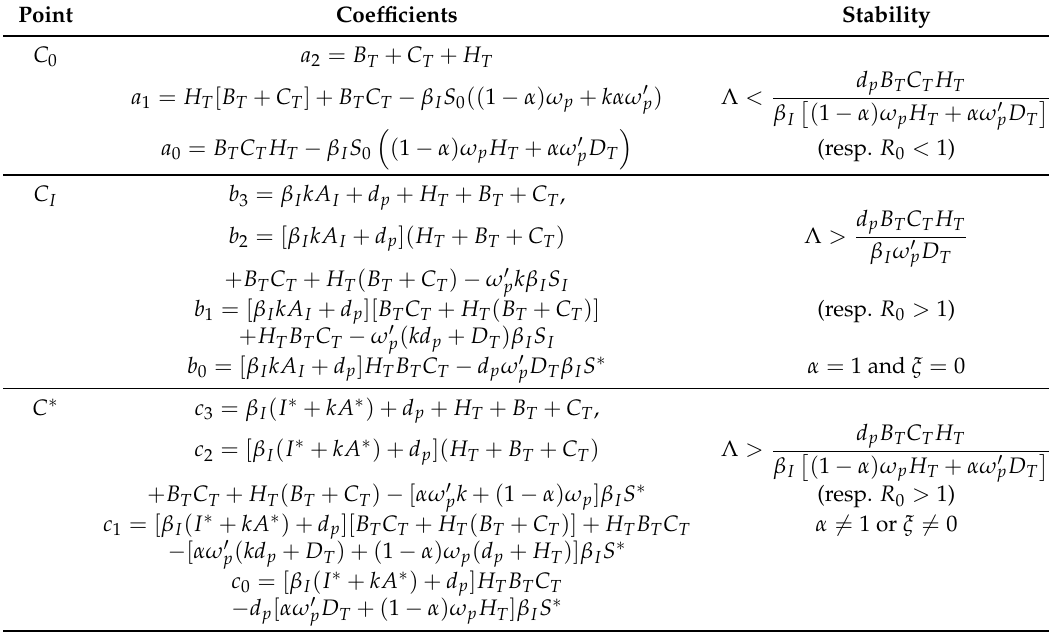
Table 2. Stability conditions of the equilibria of the model (1).